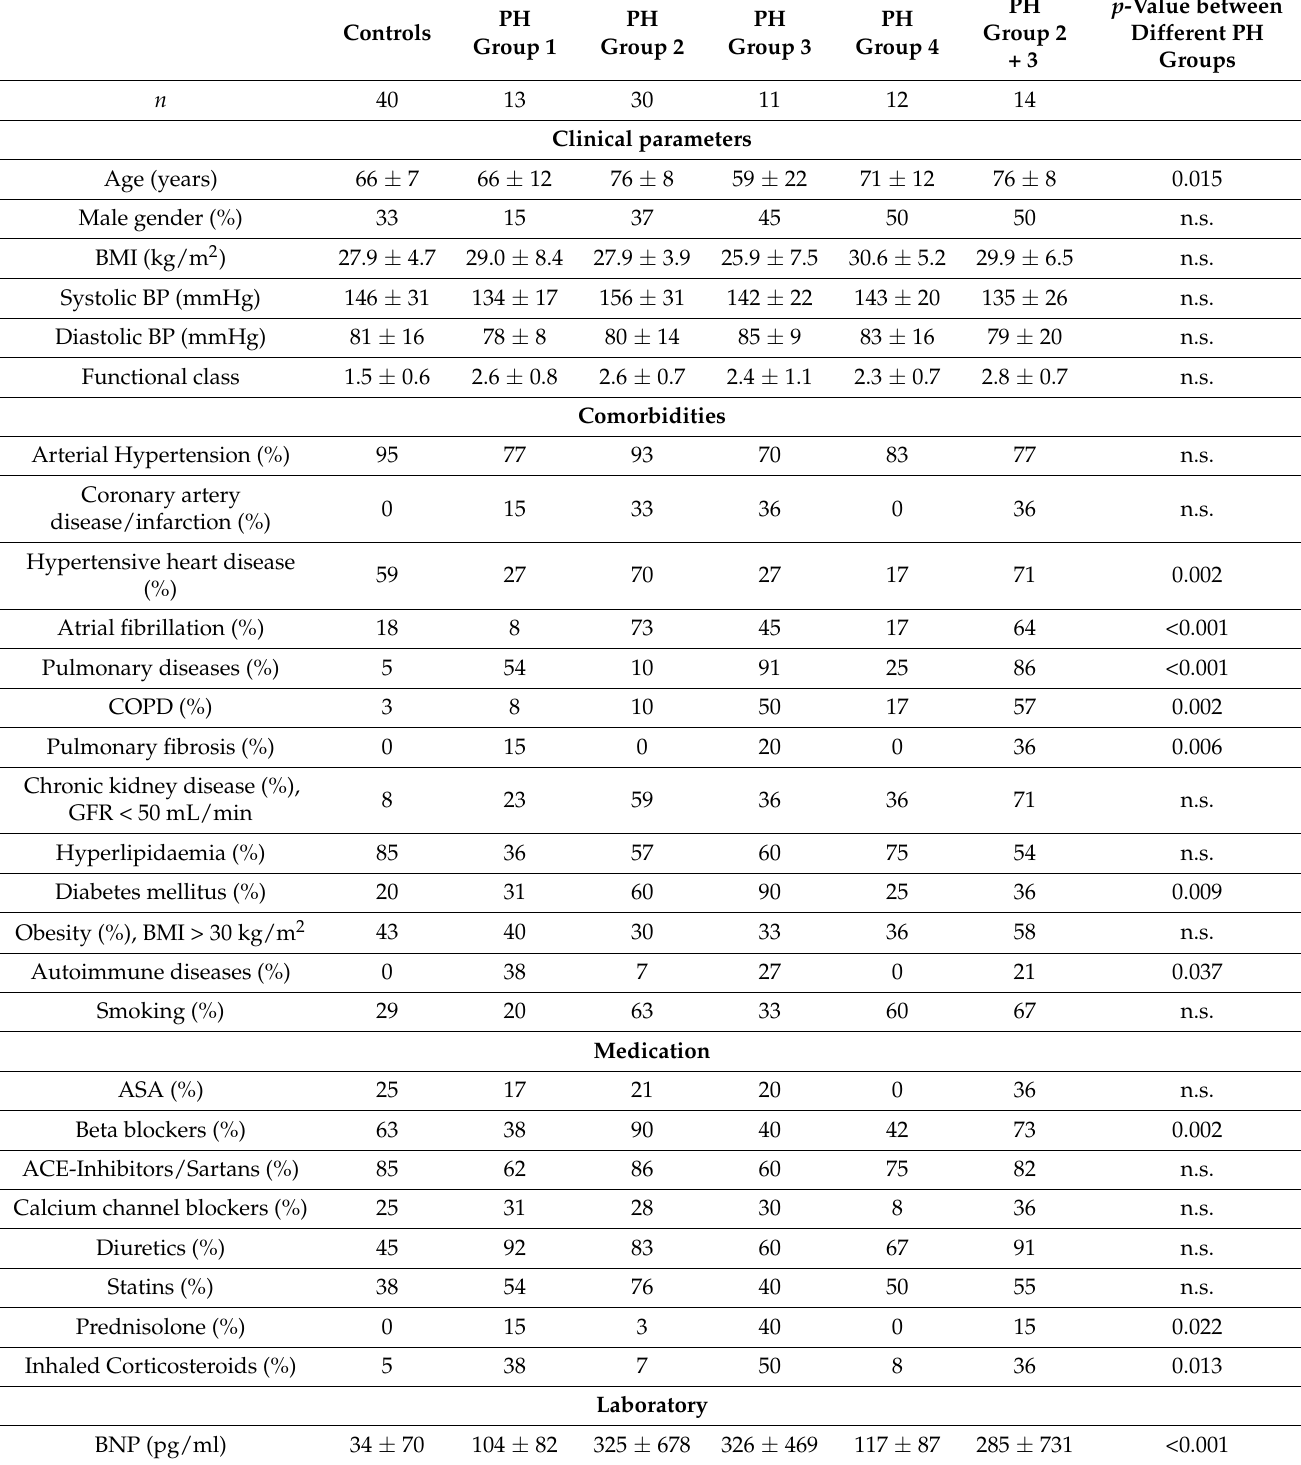
Table 2. Characteristics of the study groups in comparison between PH patient subgroups and